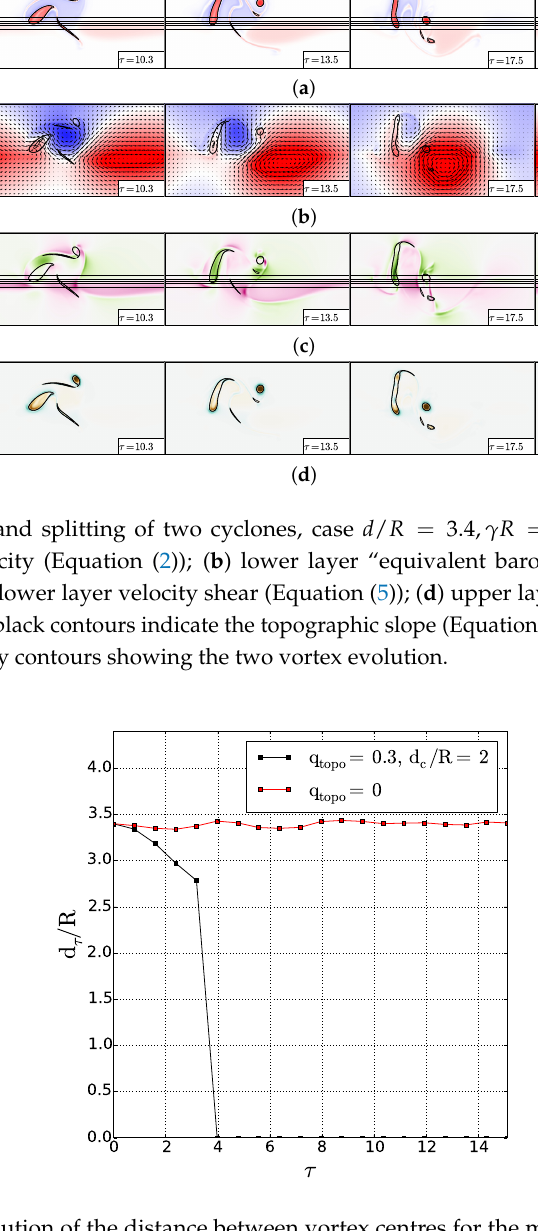
Figure 9. Time evolution of the distance between vortex centres for the merger and splitting of two cyclones; case d / R = 3.4, γ R = 3, d c / R = 2; comparison between the evolutions with and without the